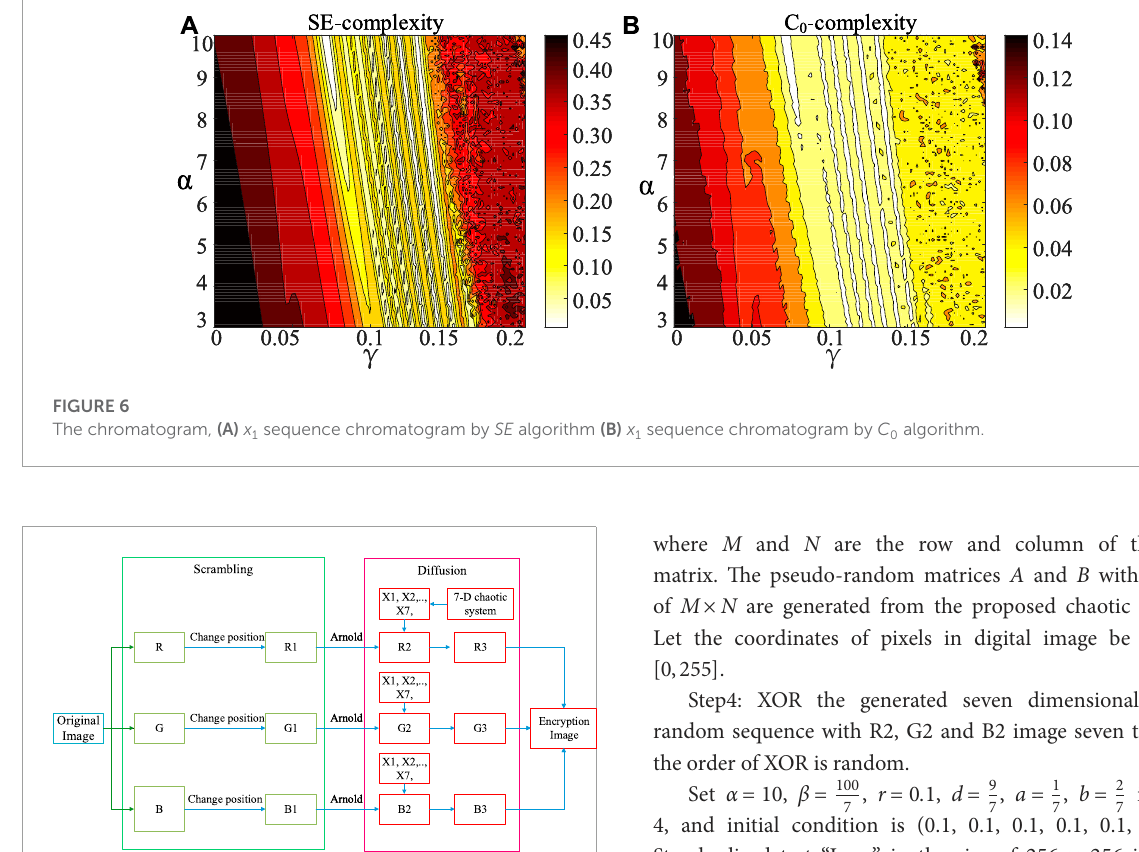
FIGURE 7 The image algorithm flow